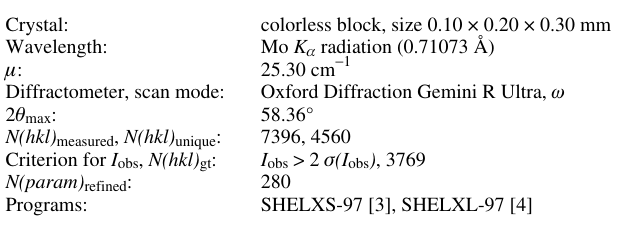
Table 1. Data collection and handling.